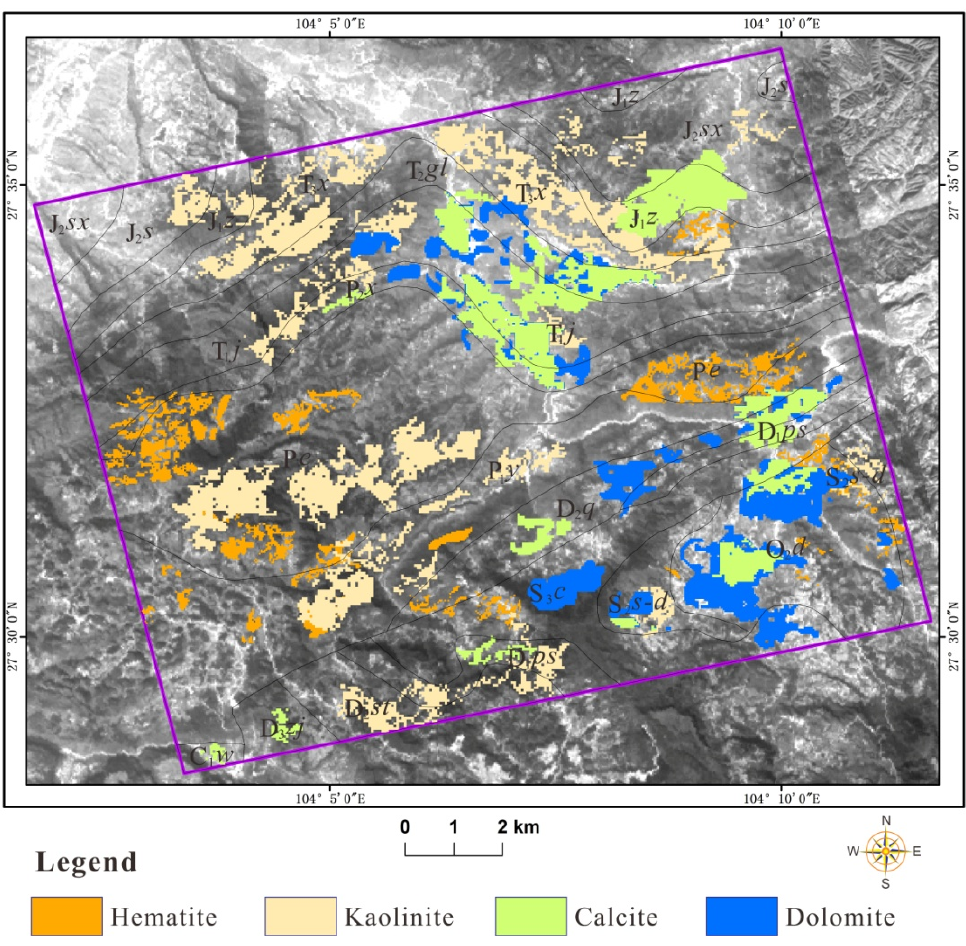
Figure 8. Mapped hydrothermal alteration minerals with GF-5 data using the MTMF method.